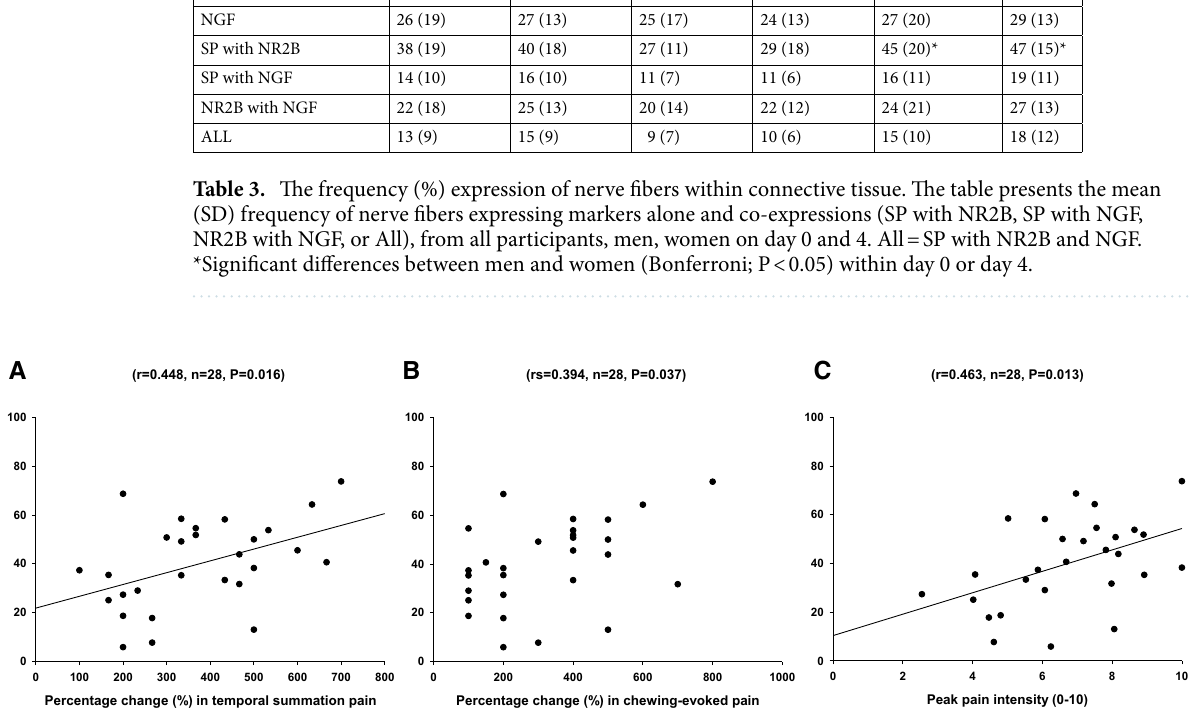
Figure 2. The scatter plot illustrates correlations between different pain characteristics and NR2B receptor expression by putative sensory afferent nerve fibers. The correlation between the co-expression of SP with NR2B by nerve fibers and the percentage change (day 3 post glutamate injection/day 0 baseline) in ( A ) temporal summation pain and ( B ) chewing-evoked pain. ( C ) is presenting the correlation of SP with NR2B co-expression with the peak pain intensity induced by injection of glutamate three days after NGF administration. r Pearson, rs Spearman correlation